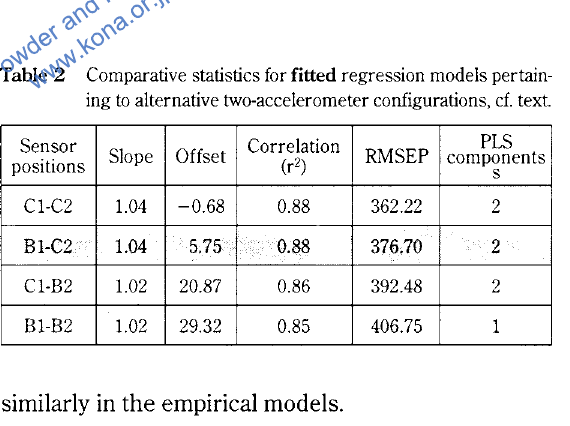
Fig. 12 Predicted vs. measured evaluation for cement